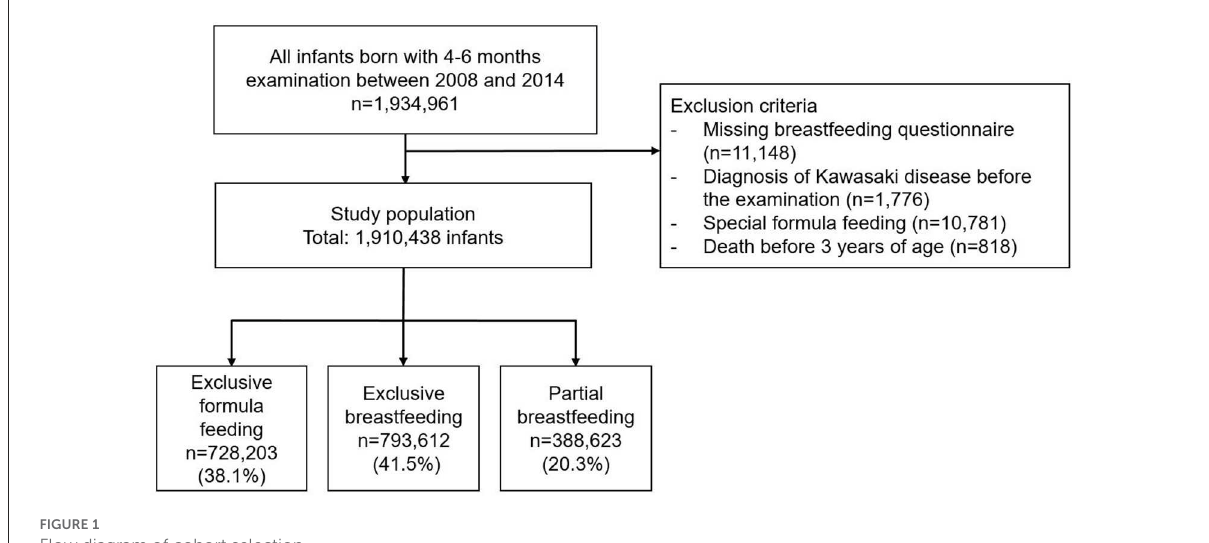
FIGURE1 Flow diagram of cohort selection.